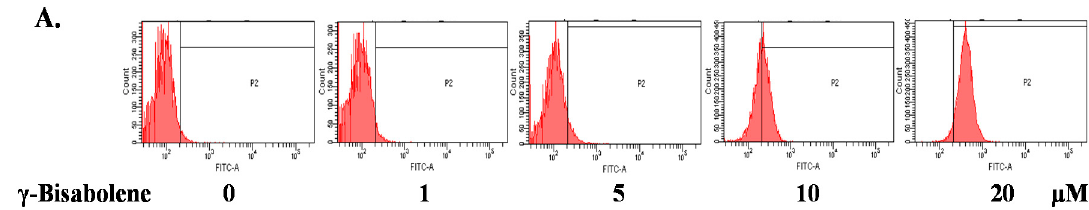
Figure 4 . Cont . Figure 4.